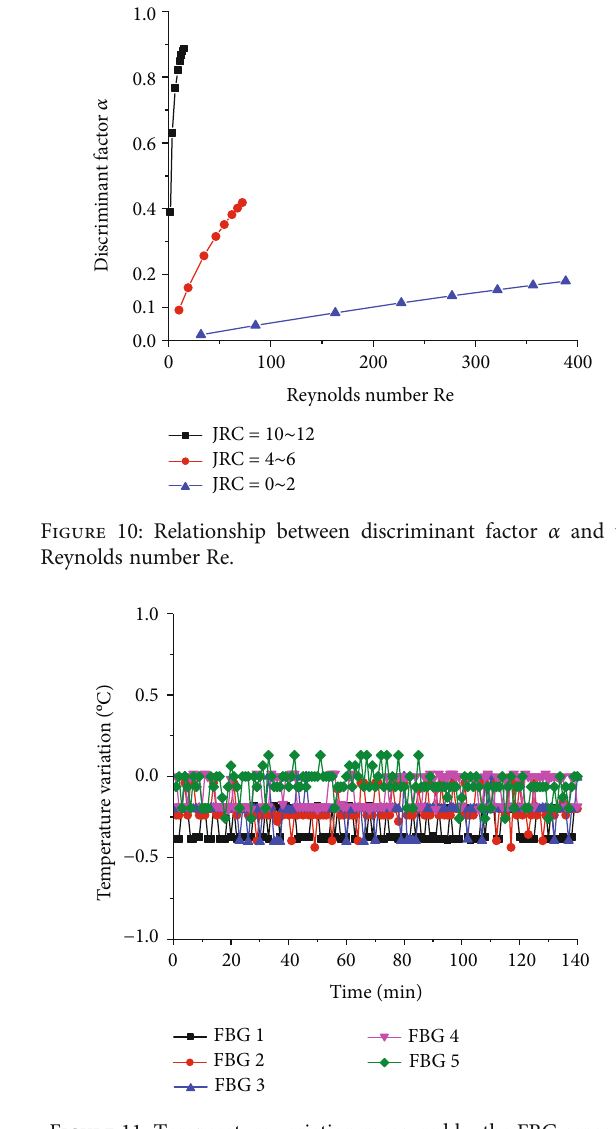
Figure 9: The variation of Re with J corresponding to di ff erent JRC .